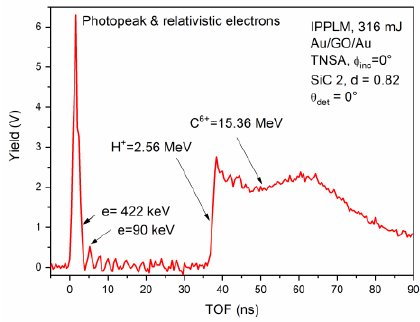
Figure 4. SiC-TOF forward spectrum obtained by irradiating a thin foil of Au/GO/Au 7 μm thick in the TNSA regime at high laser contrast.